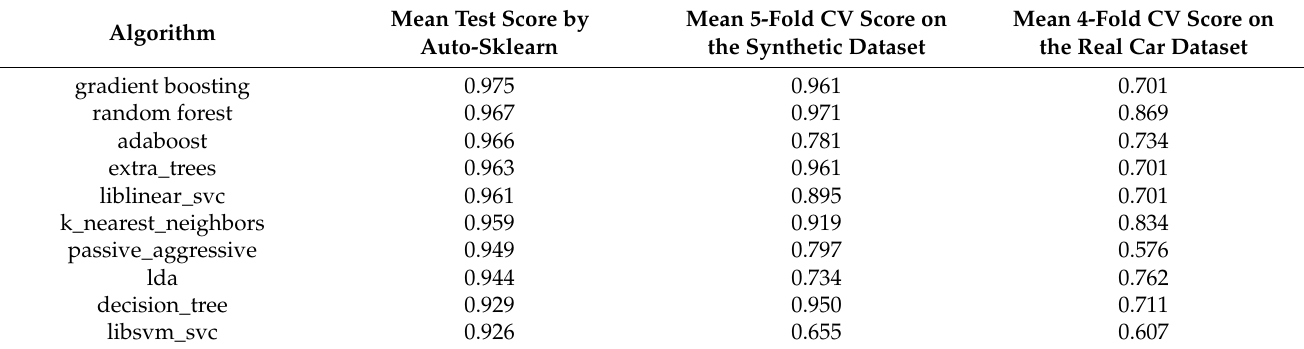
Table 8. Performance results of auto-sklearn and cross-validation scores of classification algorithms on synthetic and real-world datasets.